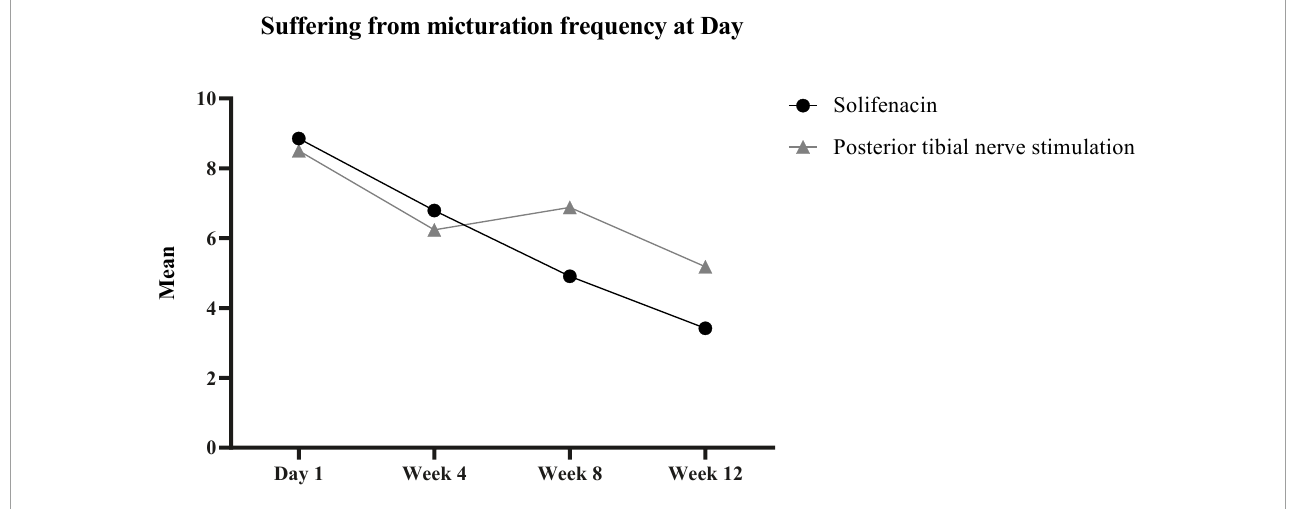
FIGURE2 The trend of changes in the micturition frequency during the 3-month